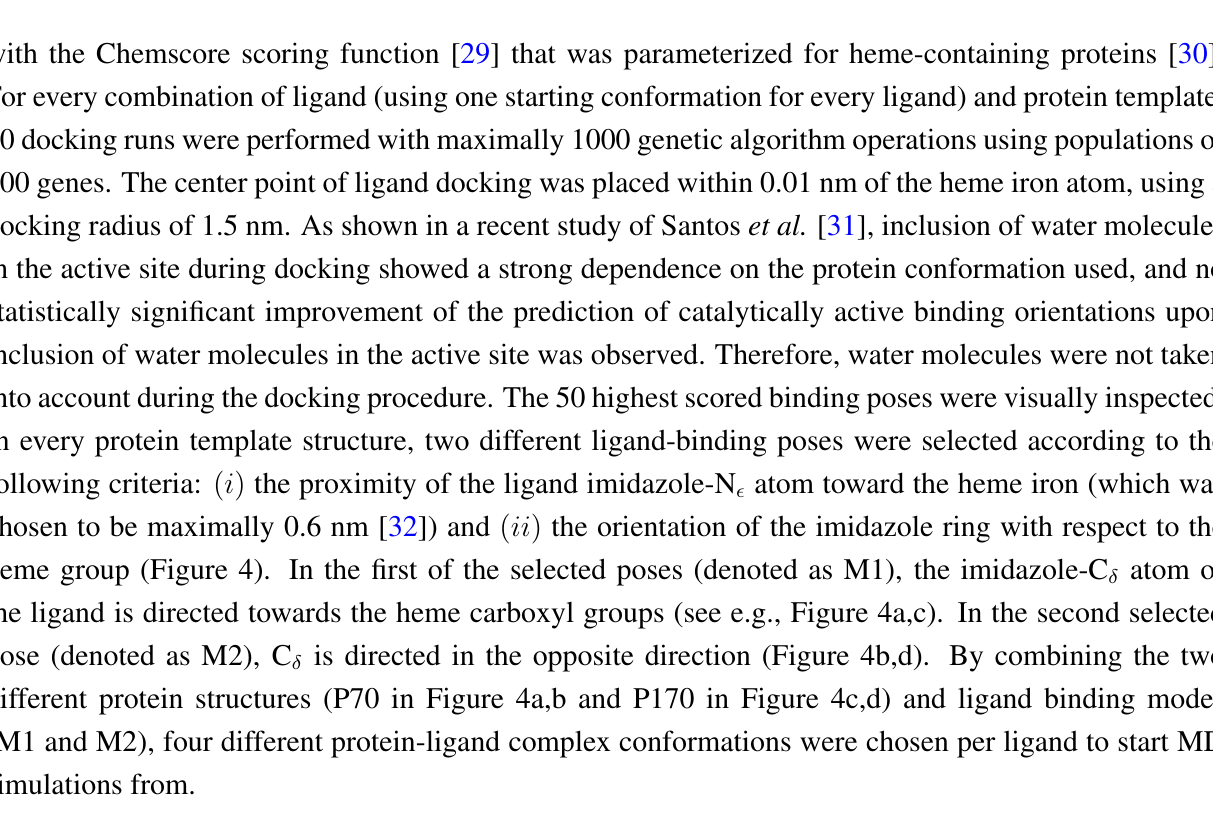
Typical ligand-binding orientations to start MD simulations from: ( a ) pose P70-M1; ( b ) pose P70-M2; ( c ) pose P170-M1; and ( d ) pose P170-M2. Residue